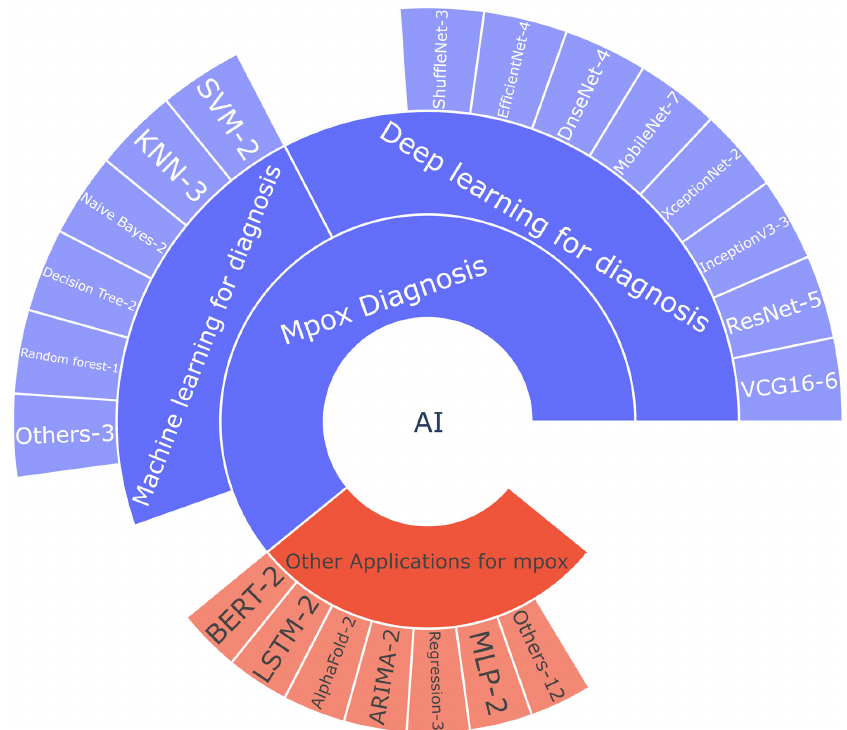
Figure 7. Sunburst plot of AI studies using Mpox data. The inner layers depict various categories of applications; the outer layers depict the algorithms used, with each corresponding use frequency indicated by a numbered suffix. For example, MobileNet ‐ 7 indicates that MobileNet has been used for mpox diagnosis in seven studies.